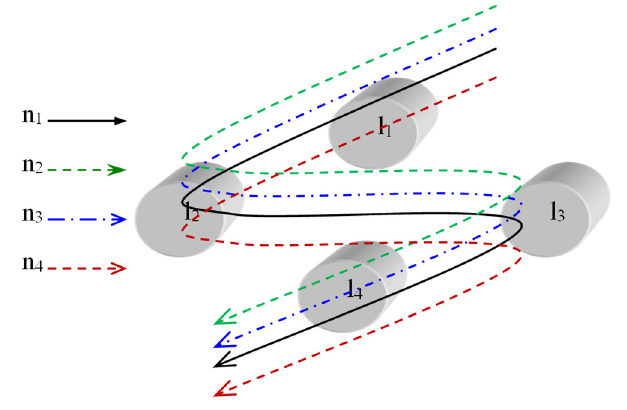
Figure 2. Process routes in the flow shop system with four tasks. Table 2. Genetic material in the DNA library for four tasks. DNA Library Generated